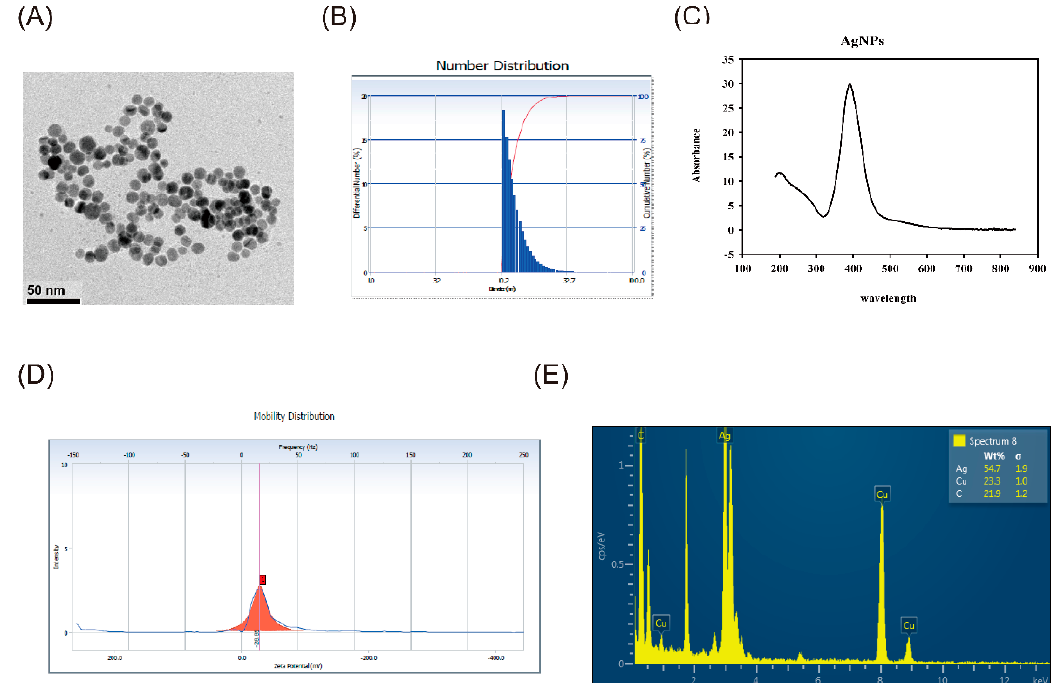
Figure 1. Characterization of Silver nanoparticles (AgNPs). ( A ) Transmission electron microscopy [18] analysis revealed that the synthesized citrate-capped AgNPs were all spherical in shape (scale bar = 50 nm). ( B ) The mean hydrodynamic size of the AgNPs determined by dynamic light scattering (DLS) is 13.2 ± 3.1 nm. The mean size of AgNPs was 8.89 ± 1.68 nm. ( C ) AgNPs were characterized by UV-visible absorption spectra and showed maximum absorbance at 391 nm. ( D ) The zeta potential was observed as a sharp peak at − 28.85 mV. ( E ) The energy dispersive X-ray (EDX) spectrum showed that the main components of the NPs are silver.